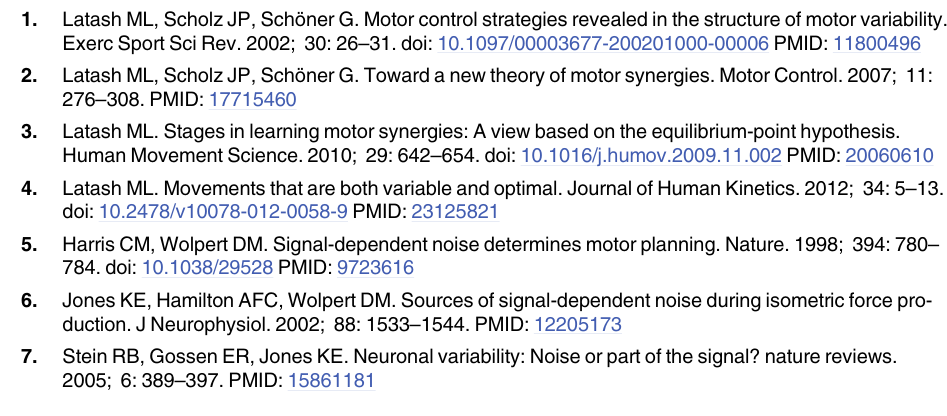
S2 Table. Specific values of the results of UCM analysis in simulation experiment shown in